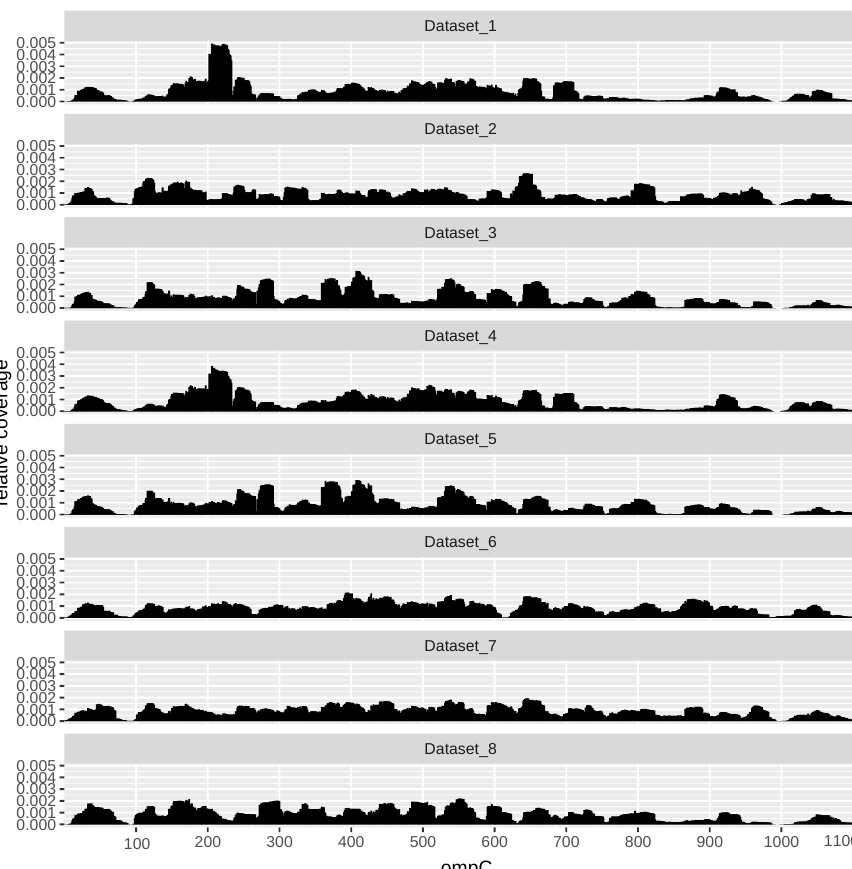
Figure 3. Example of a significantly reproducible Ribo–seq profile across the eight datasets (gene ompC, EG10670).